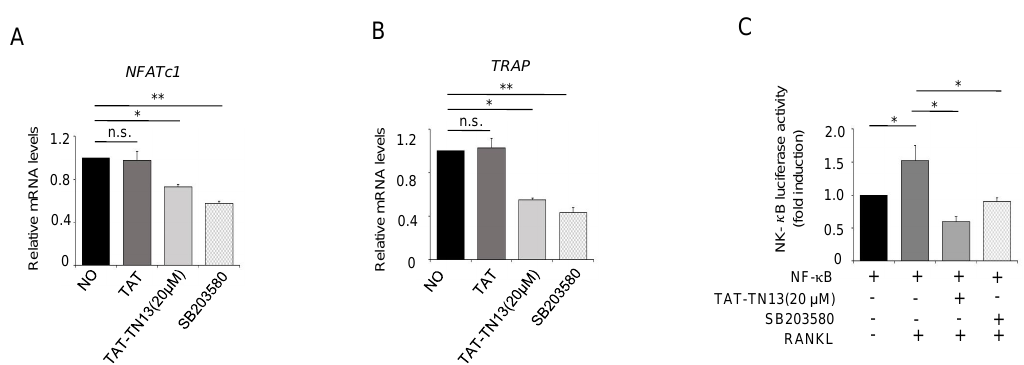
Figure 4. TAT-TN13 suppresses RANKL-induced osteoclast-specific gene expression and NF- κ B activity. ( A , B ) RAW 264.7 cells were pretreated with different concentrations of TAT-TN13 and the p38 inhibitor, SB 203580, for 1 h and then treated with RANKL (40 ng/mL) for 3 h, 12 h. Gene expression was analyzed using real-time PCR ( n = 3). ( C ) RAW 264.7 cells that were stably transfected with a NF- κ B luciferase reporter construct were pretreated with varying concentrations of TAT-TN13 for 1 h and then treated with RANKL (40 ng/mL) for 8 h. Luciferase activity was measured using a dual-luciferase reporter assay system. The results are presented as the mean ± S.D of three independent experiments (* p < 0.05 and ** p < 0.01; n.s.: not significant). NO: control, which was treated with PBS; TAT: treated control, which was treated with control